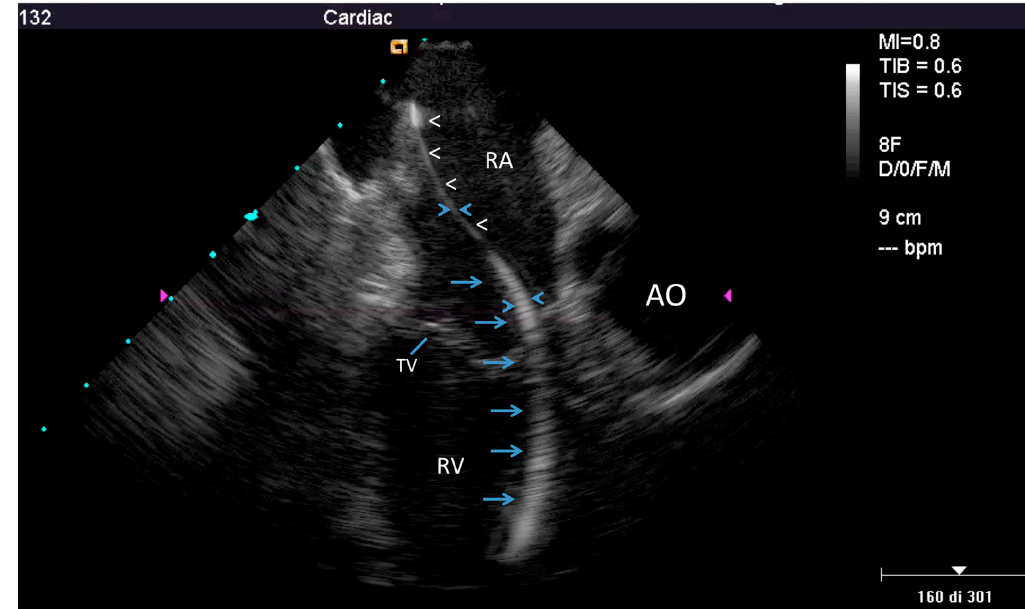
Figure 1. Example of a partially thickened lead at intracardiac echocardiography (ICE). Home view showing normal thickness of the proximal part of the lead in the right atrium (white arrow head), but evident thickening in the distal atrial part and in its ventricular course ( ≥ 4 mm, blue arrows); AO—aorta; RA—right atrium; RV—right ventricle; TV—tricuspid valve.